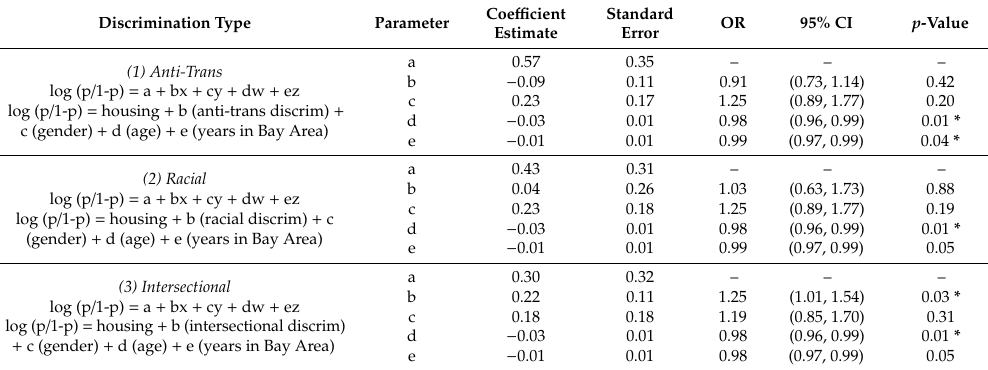
Table 2. Anti-trans, racial, or intersectional discrimination associations with housing instability among trans women in the San Francisco Bay